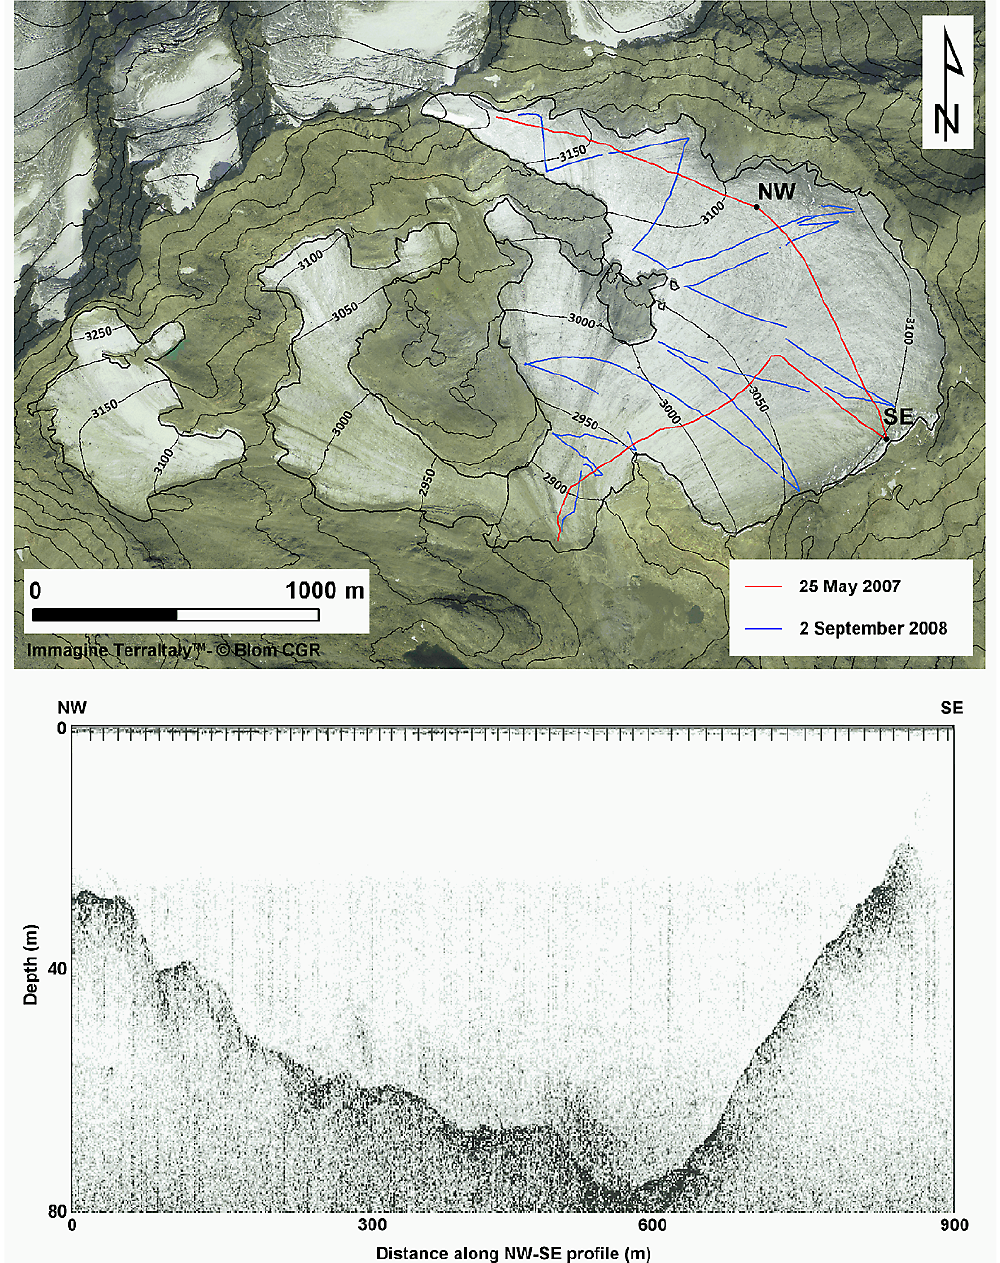
Fig. 10. Spatial coverage of the GPR profiles performed in the eastern part of the Careser Glacier in 2007 and in 2008 (upper picture). In the lower picture an example of unmigrated GPR profile for the section NW–SE is